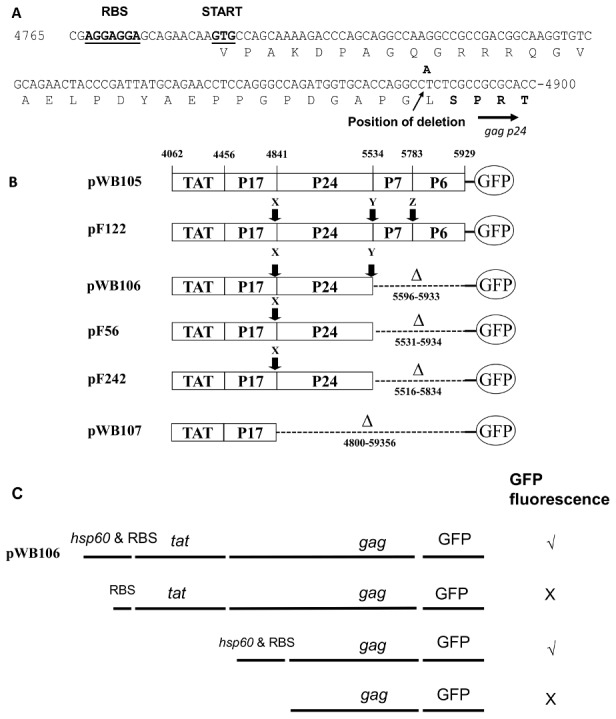
Maps and sequence of plasmids that express high levels of GFP, generated through mutation and selection.Position numbers are as for the parental plasmid pWB105.A. Potential ribosome binding site and start site utilized for P24-GFP expression in pWB106 transformants. B. Mutations found in transformants expressing high levels of p24. Mutation type symbols: X, 1 base pair deletion of an A nucleotide at position 4884 that allows expression of p24 from an internal start codon;Y, 1 bp insertion of an A nucleotide between positions 5539–5540; Z, 1 bp deletion of a C nucleotide at position 5706. Deletions (Δ) are shown with positions given to include the remaining portion. C. Map showing plasmids generated by deleting regions of plasmid pWB106 to determine whether p24-GFP is transcribed from the hsp60 promoter. GFP fluorescence indicates whether M. smegmatis transformed with these plasmids showed GFP fluorescence.